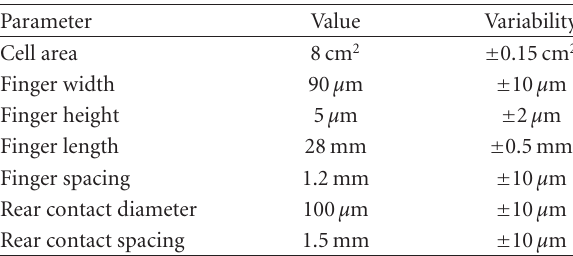
Table 2: Dimensions for cell design and analysis.